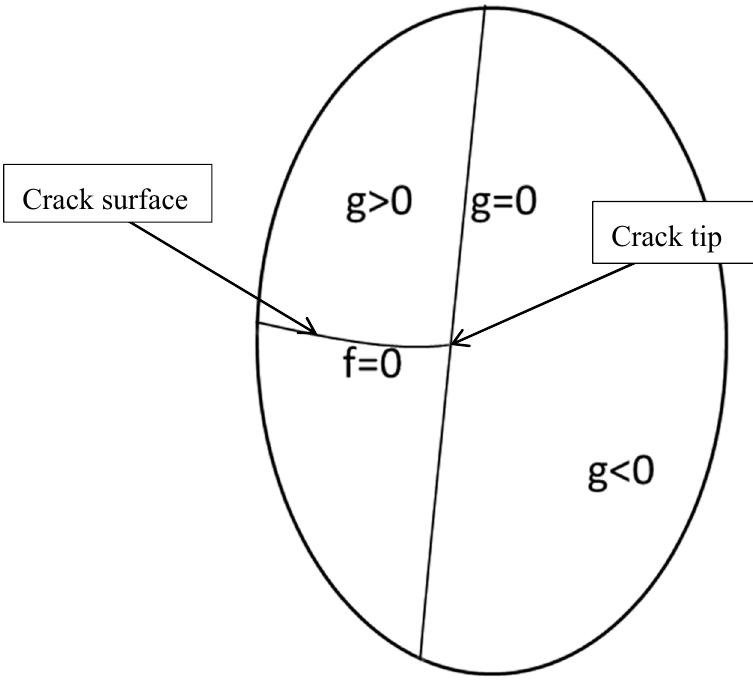
Figure 1. Crack surface described by the level set method.